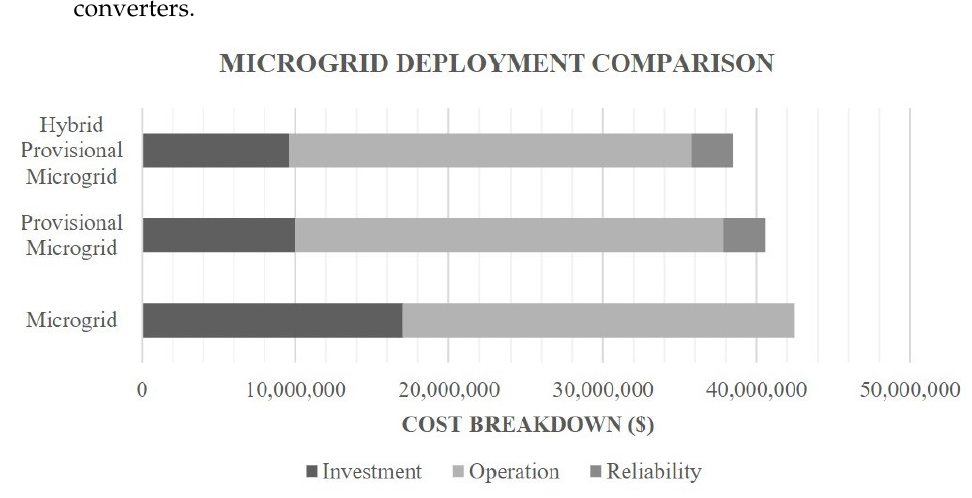
Figure 3. Microgrid deployment